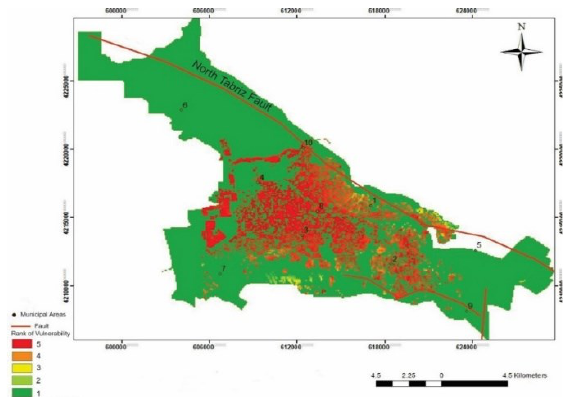
Fig. 12. Final vulnerability map of Tabriz based on oral weights